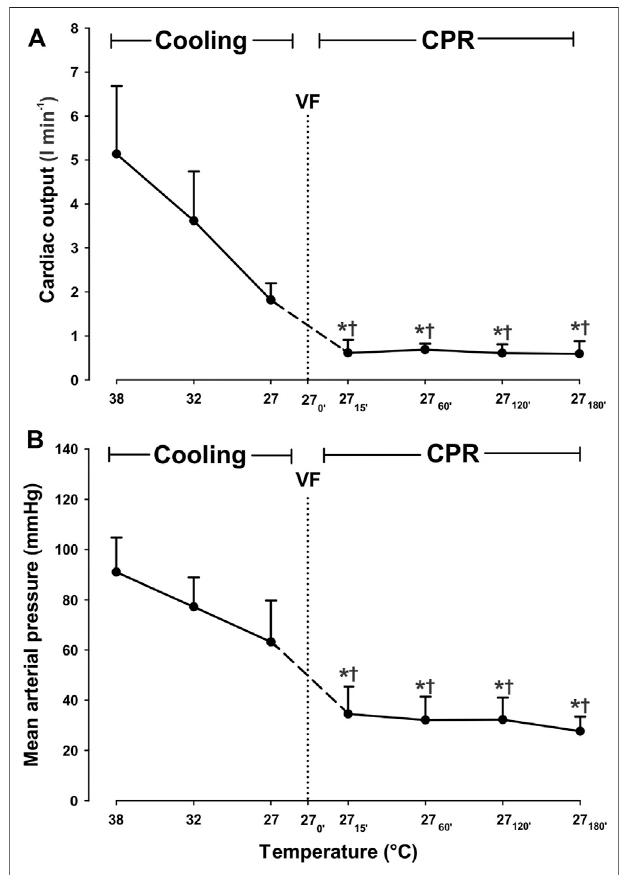
FIGURE 1 | Hemodynamic variables during cooling with sinus rhythm and 3 h CPR. (A) cardiac output, (B) mean arterial pressure. Values are mean ± SD ( n = 8). * p < 0.05 vs. intragroup 38 ° C baseline; † p < 0.05 vs. intragroup spontaneous circulation at 27 ° C VF - ventricular fi brillation.